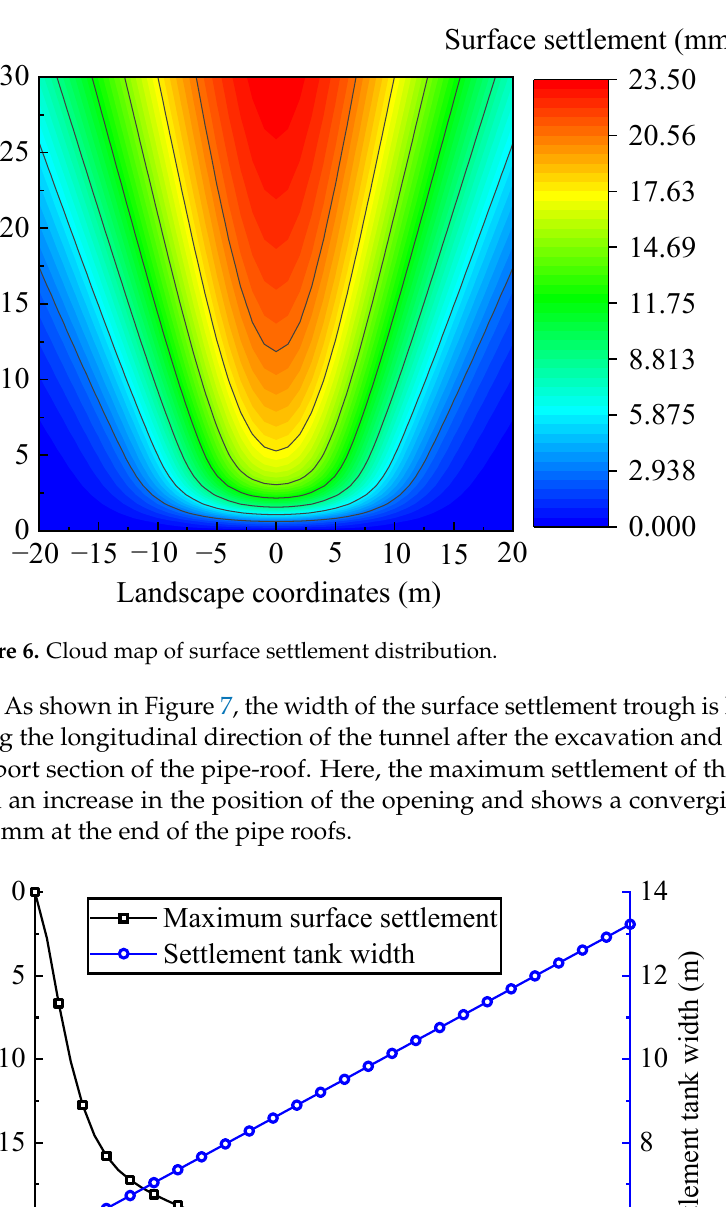
Figure 7. Distribution curve of the width of the surface settlement trough and maximum surface settlement.